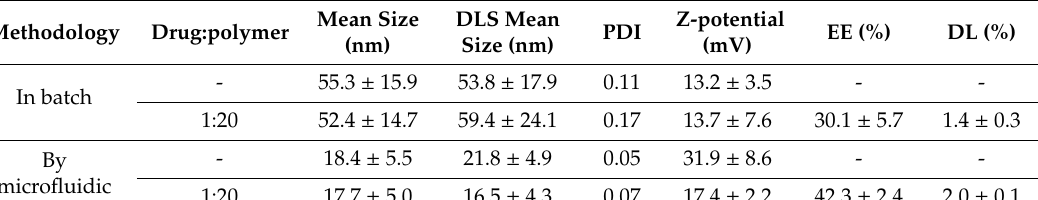
Table 7. Size, DLS mean size, PDI, Z-potential, encapsulation efficiency (EE) and drug loading (DL) of rifampicin-loaded nanoparticles synthesized by batch and by microfluidic methodologies. Methodology